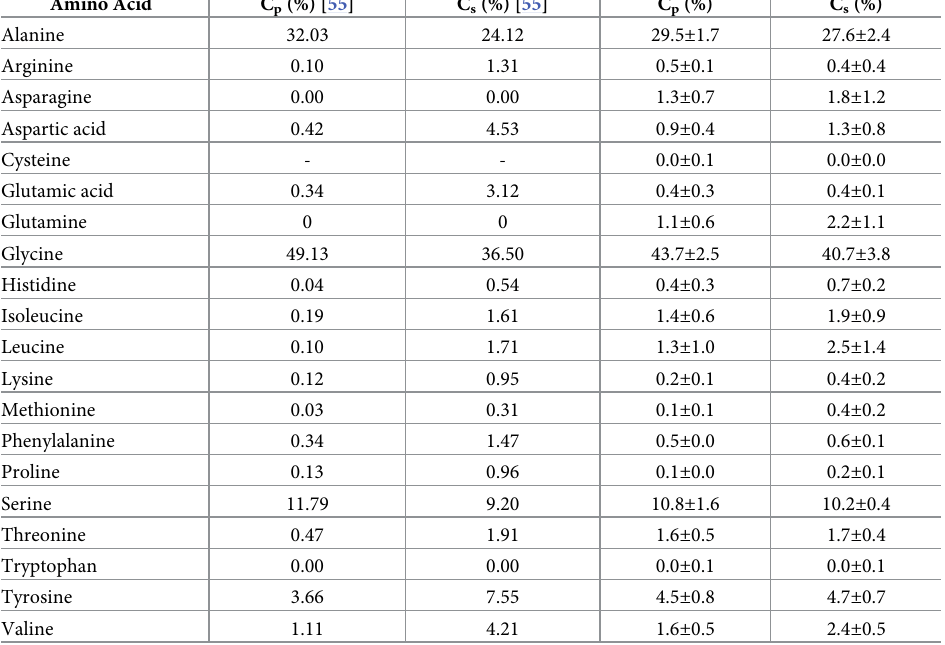
Table 2. Comparison of amino acid composition for fibroin-derived polypeptides, C p and C s , obtained from LCMS (Right–from literature, left–as-made). Amino Acid